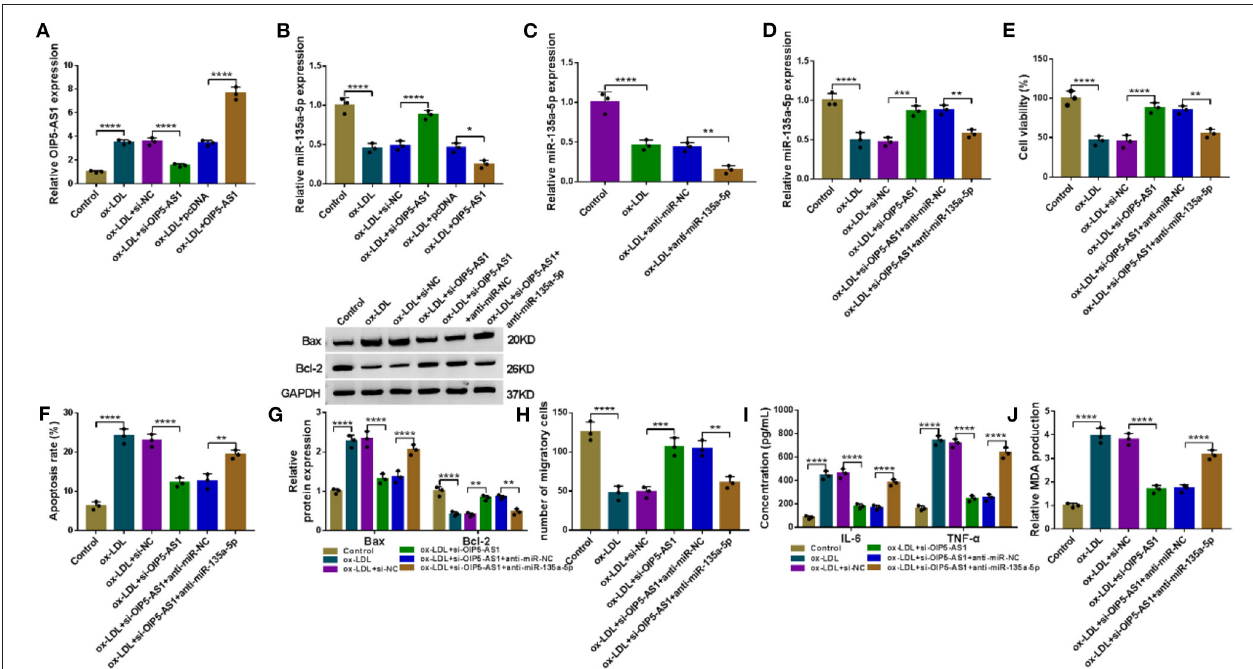
FIGURE 4 | OIP5-AS1 silencing mitigated ox-LDL-triggered HUVEC damage by upregulating miR-135a-5p. The levels of OIP5-AS1 (A) and miR-135a-5p (B) by qRT-PCR in HUVECs transfected with si-NC, si-OIP5-AS1, pcDNA, or OIP5-AS1 before ox-LDL stimulation. pcDNA: negative control, OIP5-AS1: OIP5-AS1-overexpressing plasmid. (C) MiR-135a-5p expression by qRT-PCR in HUVECs transfected with anti-miR-NC or anti-miR-135a-5p before ox-LDL stimulation. MiR-135a-5p expression by qRT-PCR (D) , cell viability by CCK-8 assay (E) , cell apoptosis by flow cytometry (F) , Bax and Bcl-2 level by western blot (G) , cell migration by Transwell assay (H) , and IL-6, TNF- α , and MDA levels by ELISA (I,J) in HUVECs transfected with si-NC, si-OIP5-AS1, si-OIP5-AS1 + anti-miR-NC, or si-OIP5-AS1 + anti-miR-135a-5p before ox-LDL stimulation (40 µ g/ml, 24h). n = 3 independent biological replicates; error bars represented SD; * P < 0.05, ** P <